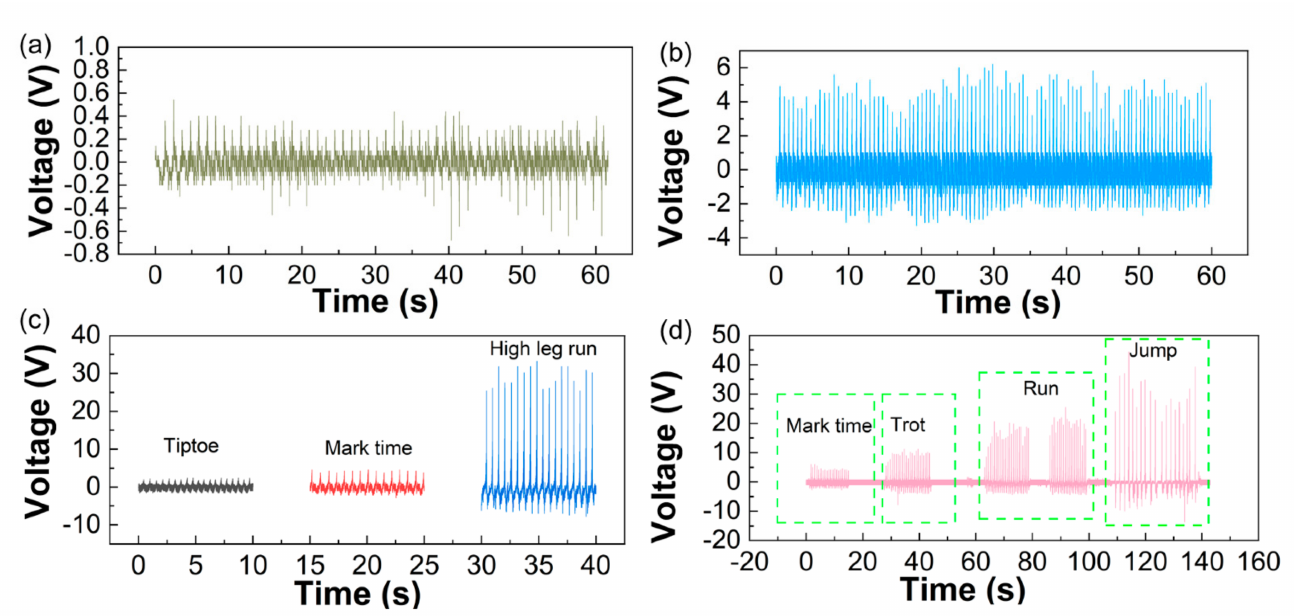
Figure 4. The TENG monitor body motion. ( a ) The output voltage of the TENG with “sandwich” structure. ( b ) The output voltage of TENG with optimized structure. ( c ) The output voltage of the move in situ of TENG. ( d ) The output voltage of the